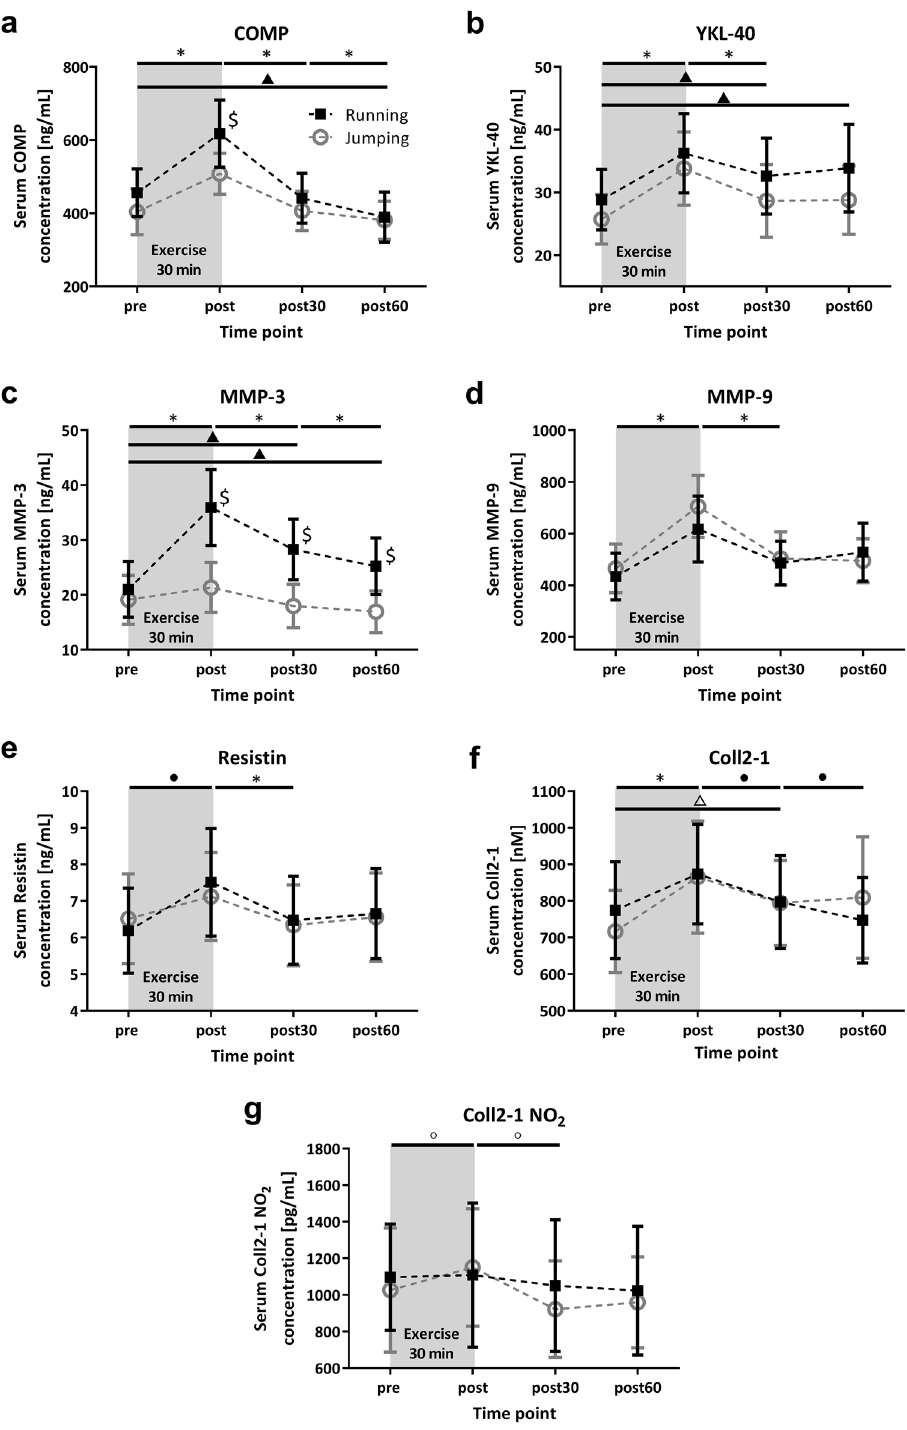
Figure 2. Mean (95% CI) serum ( a ) COMP (N = 14), ( b ) YKL-40 (N = 15), ( c ) MMP-3 (N = 15), ( d ) MMP-9 (N = 15), ( e ) resistin (N = 15), ( f ) Coll2-1 (N = 14) and ( g ) Coll2-1 NO 2 (N = 14) concentrations before (pre), immediately (post), 30 min (post30), and 60 min (post60) after running and jumping exercise. * p < 0.05 significantly different from the preceding time point for both exercises. • p < 0.05 significantly different from preceding time point for the running exercise. ° p < 0.05 significantly different from the preceding time point for jumping exercise. ▲ p < 0.05 significantly different from the pre time point for the running exercise. △ p < 0.01 significantly different from the pre time point for jumping exercise. $ p < 0.05 indicates a significant difference between the running and jumping exercise groups at the same time